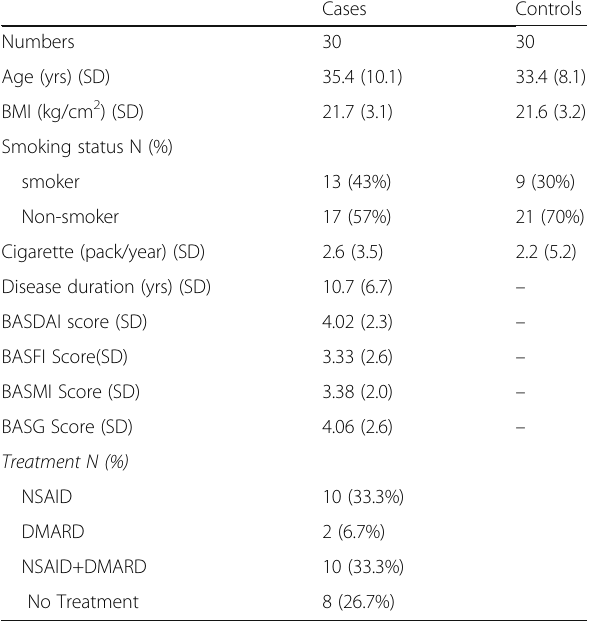
Table 1 Demographic characteristics of AS patients and controls